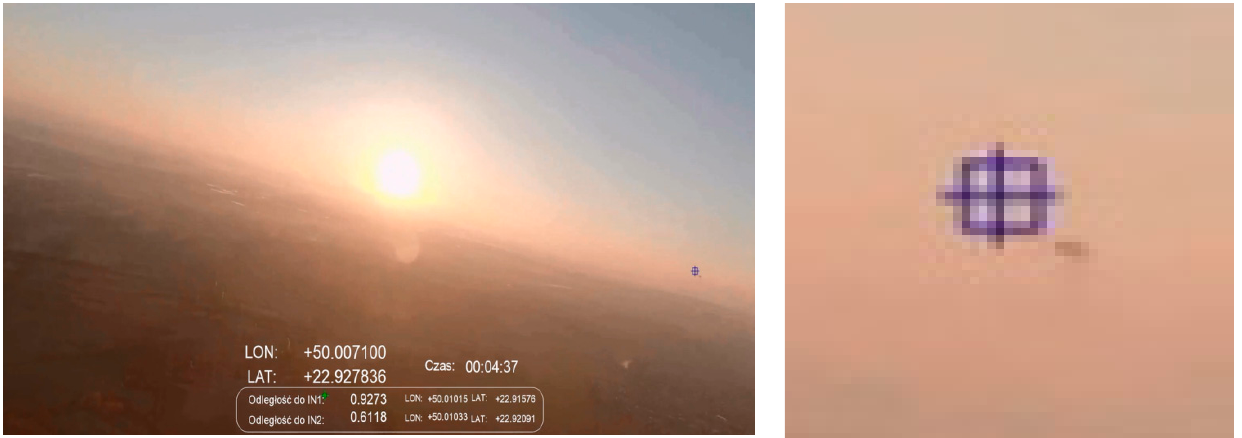
Figure 11. Scenario related to Figure 5B; late afternoon, altitude ~500 m, distance to intruder: 830 m.